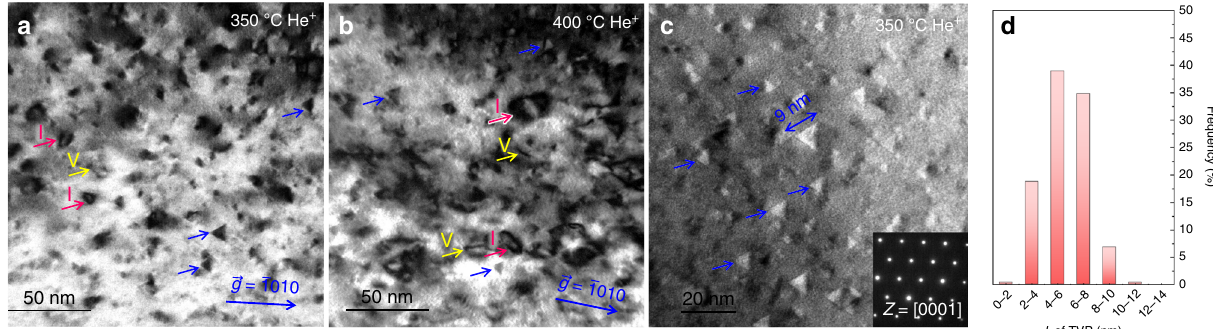
Fig. 3 Triangle-shaped defects in helium implanted Zr. a and b Profuse triangle-shaped defects and <a> loops (with edge-on orientation) co-exist in Zr. Red arrows label the <a> interstitial loops and yellow arrows mark the <a> vacancy loops. The viewing direction is [0001]. c The triangle-shaped defect has equilateral edges along the prismatic planes (defocus of − 1000 nm). d The size distribution of TVPs. 255 TVPs were involved in the